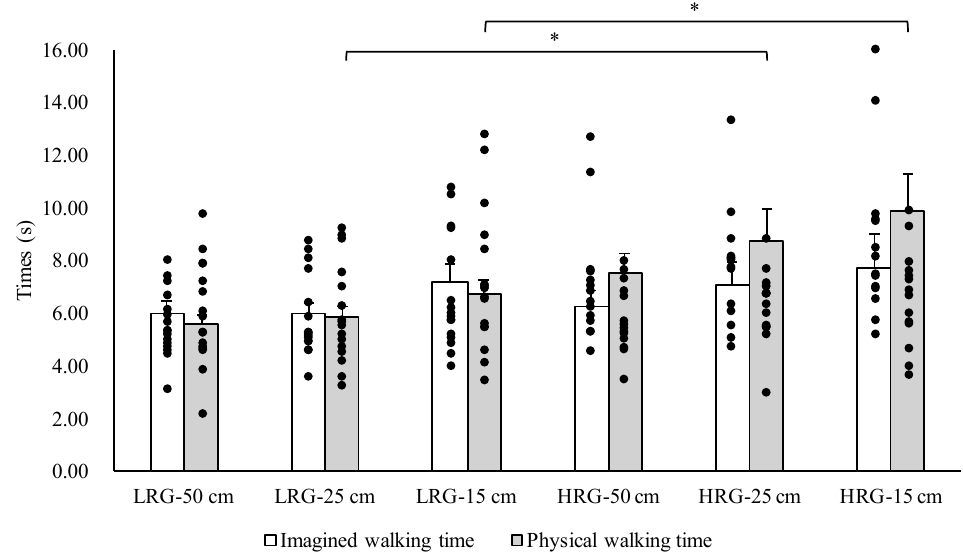
Figure 1. Comparison of the imagined and physical walking times of the high-risk group (HRG) and low-risk group (LRG) for each of the three walkway widths. Data are shown as the mean ± standard error. * p < 0.05.